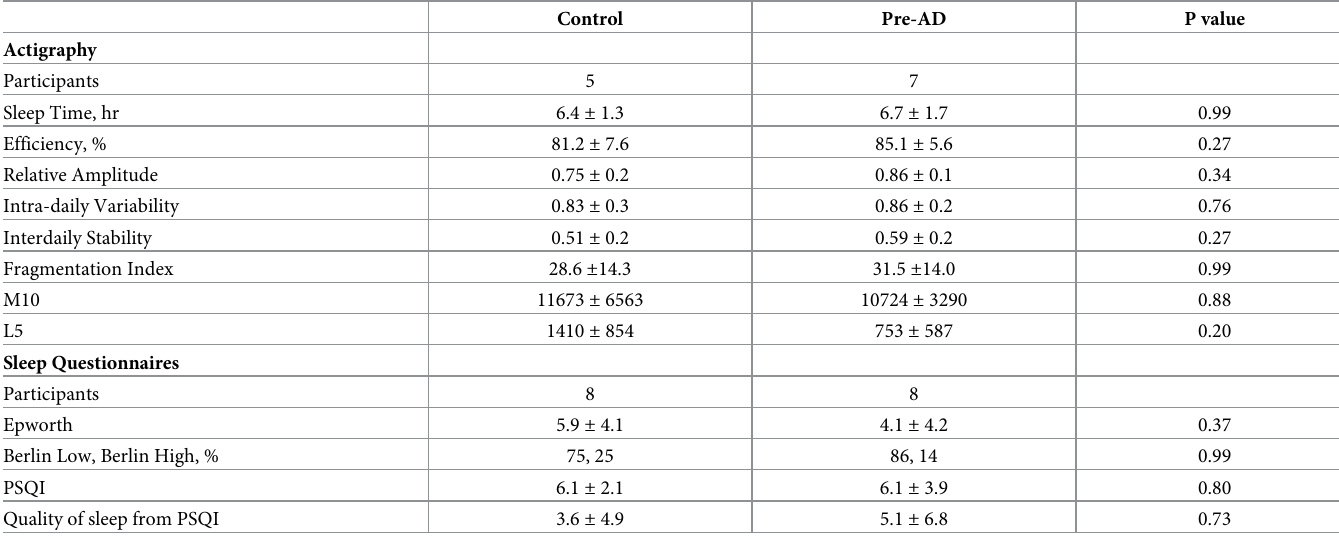
Table 3. Wrist actigraphy and sleep quality